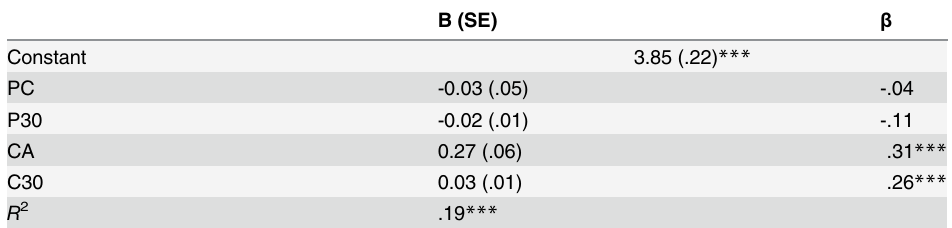
Table 4. Regression Analysis for Predictors of Negative News Headlines (Study